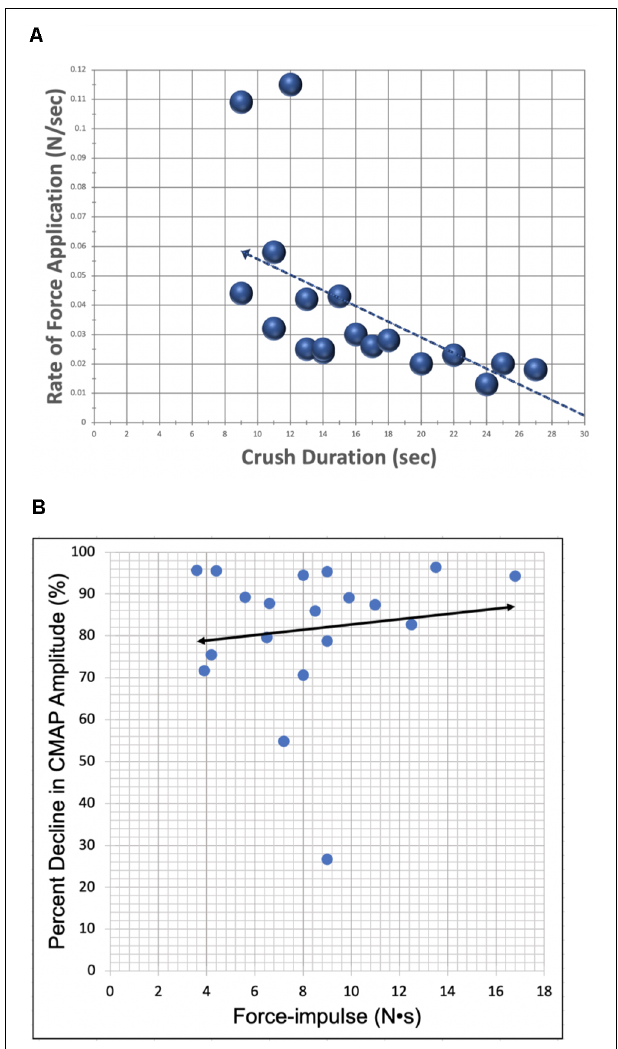
FIGURE 6 | Scatter plots demonstrating correlation between lesion parameters. (A) The relationship between the rate of force application (y-axis) and crush duration (x-axis) for all crush trials ( N = 19). Correlation ( r = − 0.609) was found to be statistically significant with a p -value = 0.006. (B) The relationship between percent decrease in CMAP amplitude (y-axis) and applied F-i (x-axis) for all crush trials ( N = 19). Bivariate correlation between variables was found to be statistically insignificant, likely due to the relatively low power of this